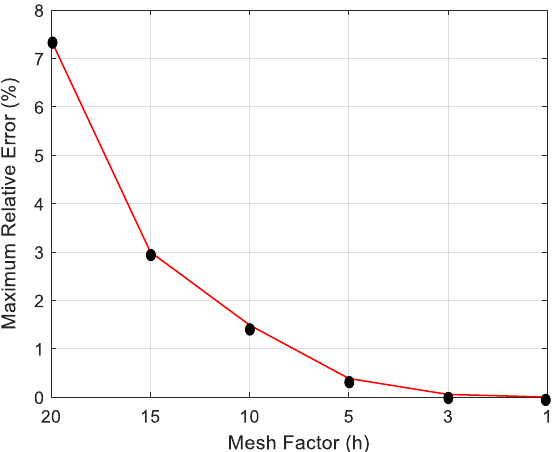
Figure 10. Maximum relative error as function of the mesh-factor. Table 4. Mesh-factor and Mash size values.